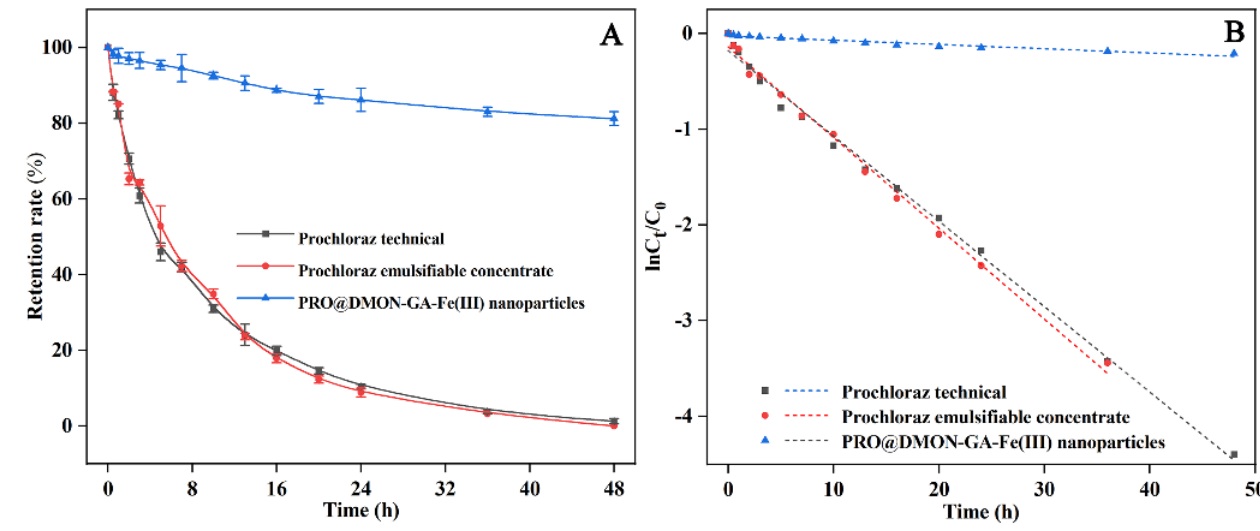
Figure 7. Stabilities of prochloraz technical, prochloraz emulsifiable concentrate, and PRO@DMON–GA–Fe(III) nanoparticles under UV radiation ( A ). Pseudo-first-order models of prochloraz photodegradation for prochloraz technical, prochloraz emulsifiable concentrate, and PRO@DMON–GA– Fe(III) nanoparticles ( B ). Table 3. Modeling parameters for photodegradation of prochloraz technical, prochloraz emulsifiable concentrate, and PRO@DMON–GA–Fe(III) nanoparticles under UV